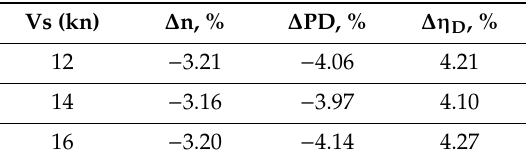
Table 8. Relative changes in propeller RPM, shaft delivered power, and propulsive efficiency due to the installation of PSS. (PSS-Var-5, full scale).